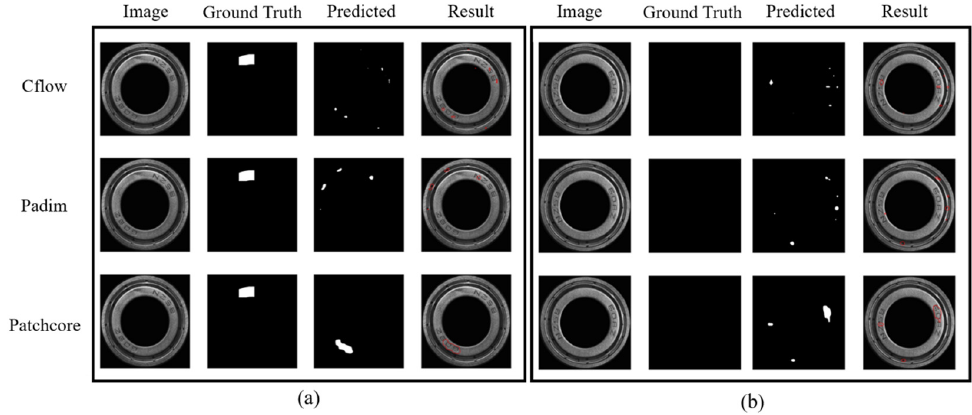
Figure 2. The result of defect detection with unsupervised methods. ( a ) the resulting image for defective data; ( b ) the resulting image for non-defective data.